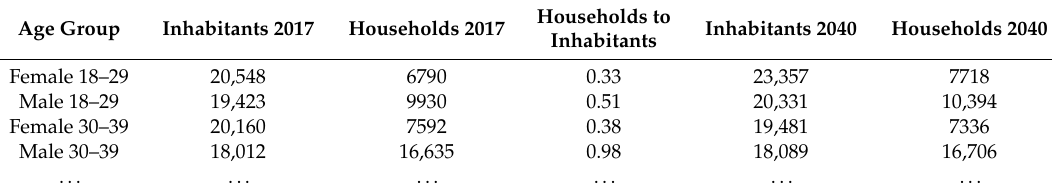
Table A4. Inhabitants and households in 2017 and projections for 2040.